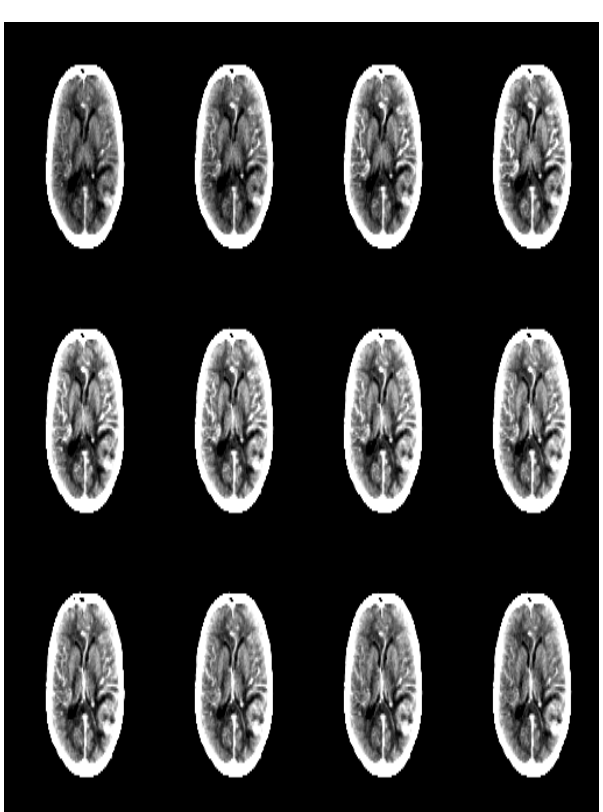
Fig.2. A sample of DCE-CT series images